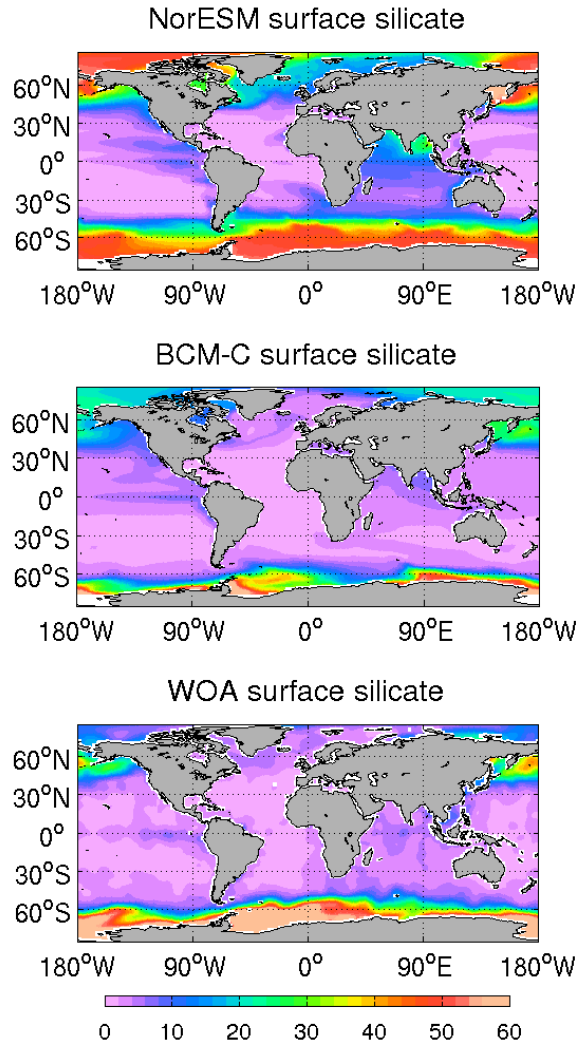
Fig. 12. Comparison between mean surface silicate concentration (1980–1999) simulated by the NorESM (top) and the Bergen Earth system model (middle), and climatological estimates (bottom) from the WOA (Garcia et al., 2010b). Units are in (µmolL − 1